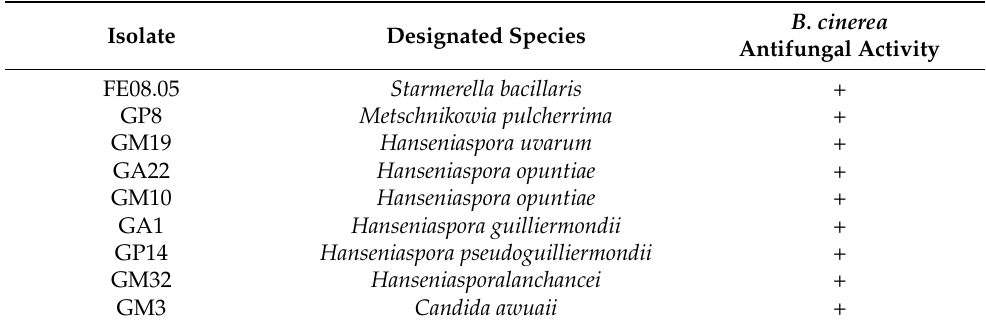
Table 2. Yeast strains isolated from grape berries and characterized by in vitro antifungal activity against Botrytis cinerea